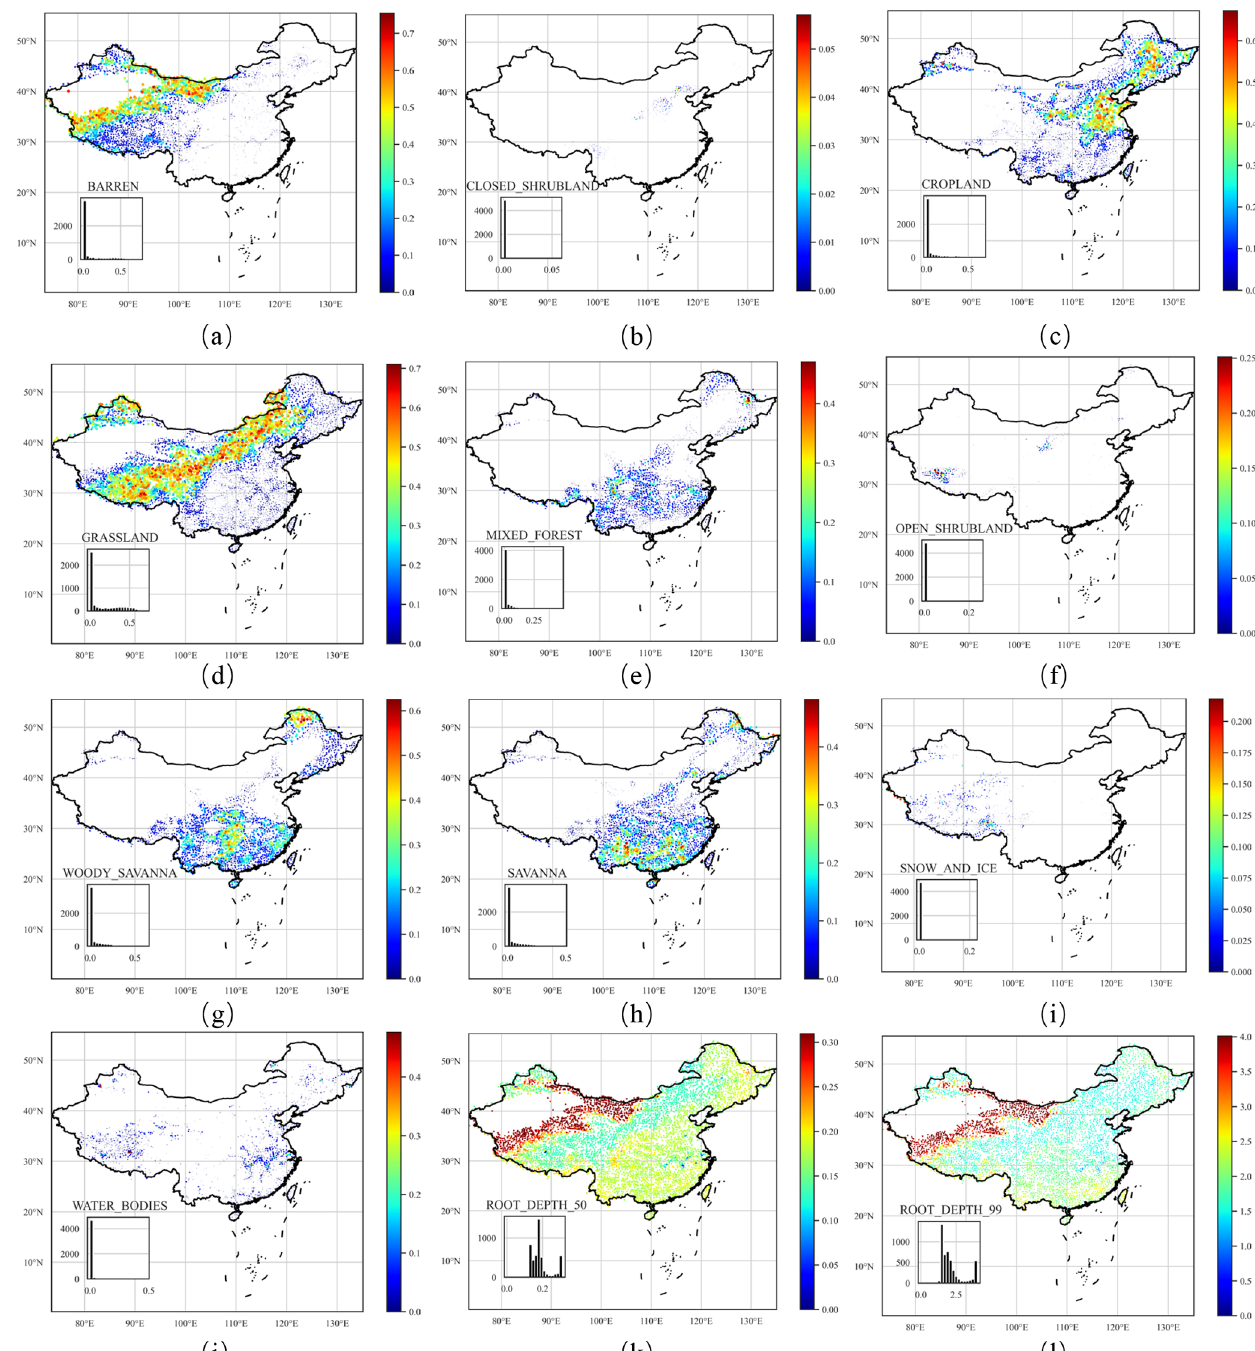
Figure 5. Distributions of land cover characteristics throughout China. For land cover types, the plot size is scaled by the size of the land cover